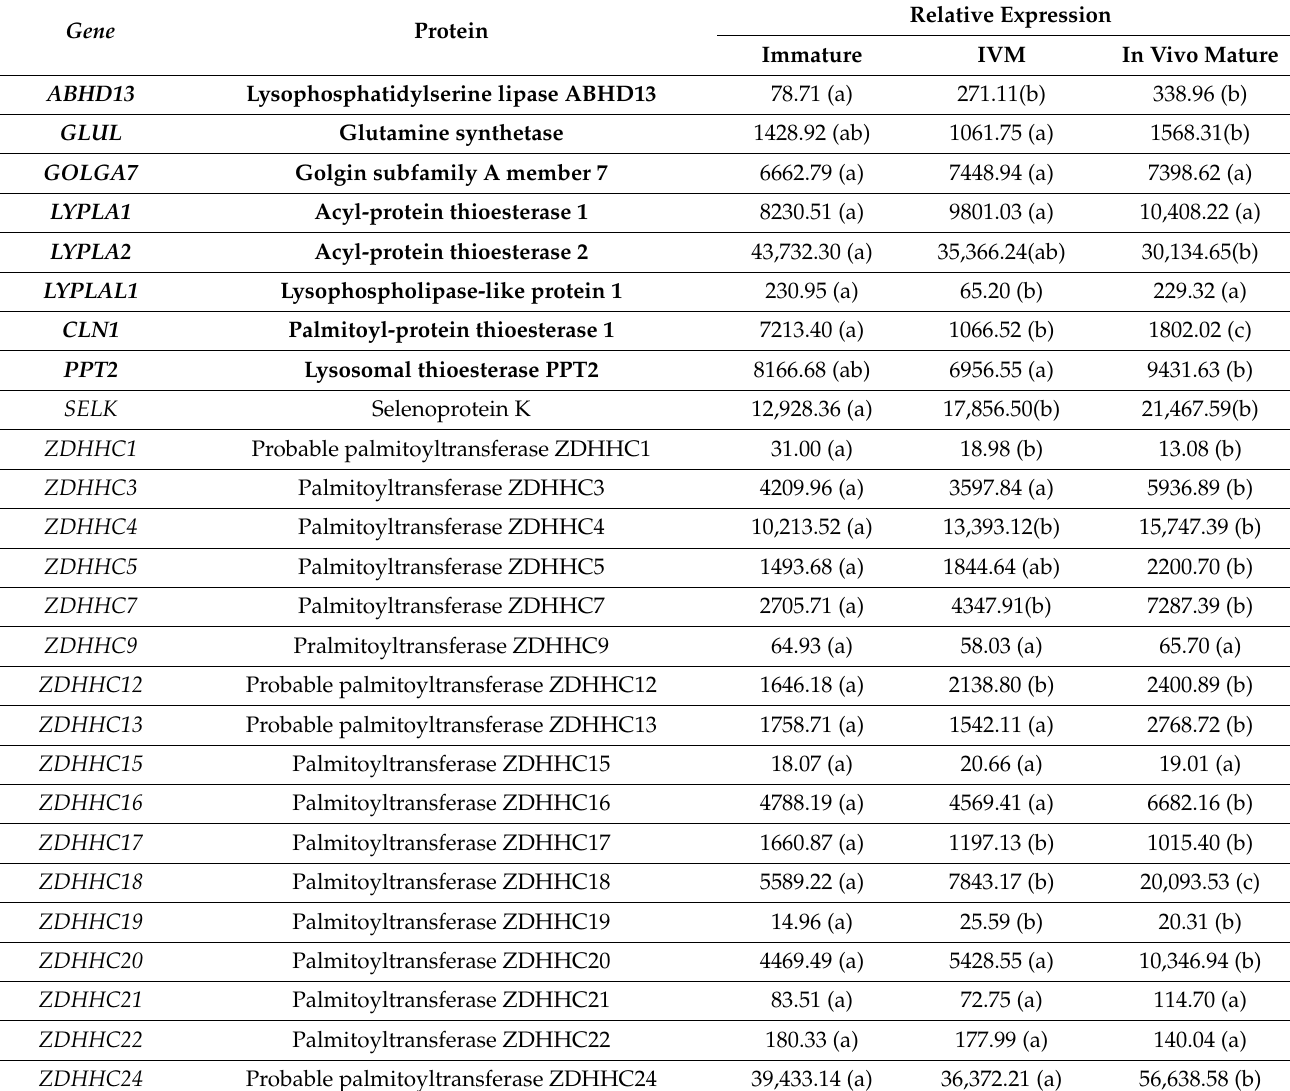
Table A1. Differential analysis of expression of the enzymes involved in protein palmitoylation (GO:0018345) and depalmi- toylation (GO:0002084, marked in bold ) in bovine cumulus cells (CC) surrounding the oocyte before(immature) and after maturation in vivo, or in vitro (IVM). Mean values of relative expression of four independent samples from microarray data are shown for each gene. Different letters signify difference at p < 0.05 (ANOVA and post-hoc